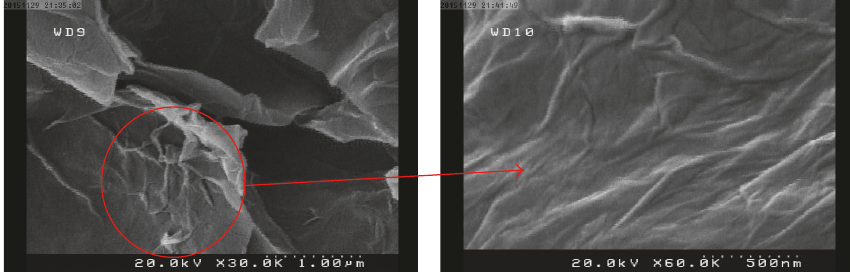
Figure 8: SEM images of electroreduced GO sheets produced by modified Hammers method from graphite flakes.